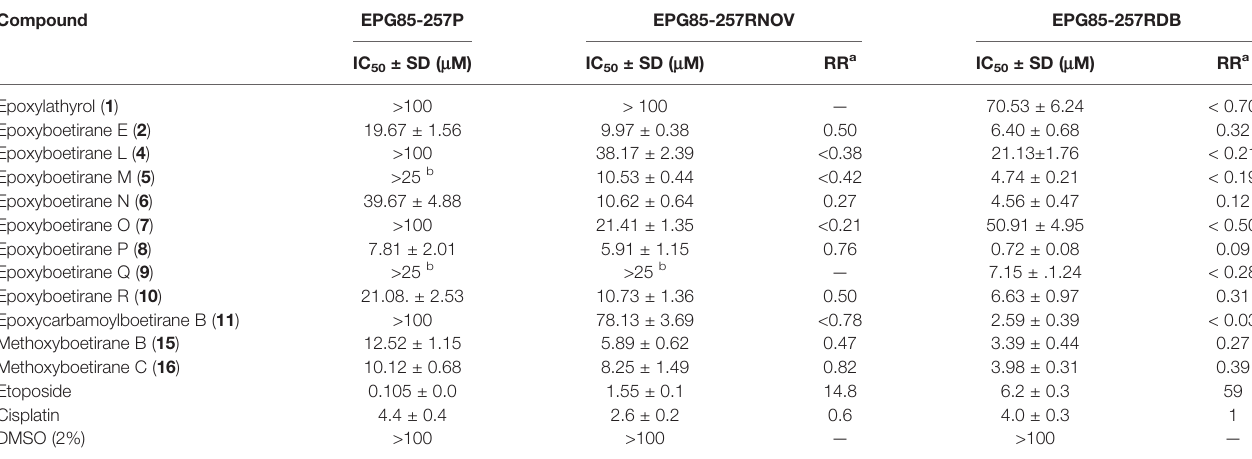
TABLE 2 | Antiproliferative activity of compounds 1 – 16 in gastric carcinoma cells: EPG85-257P (parental), EPG85-257RNOV (multidrug resistance [MDR] phenotype), and EPG85-257RDB (multidrug resistance [MDR] phenotype).